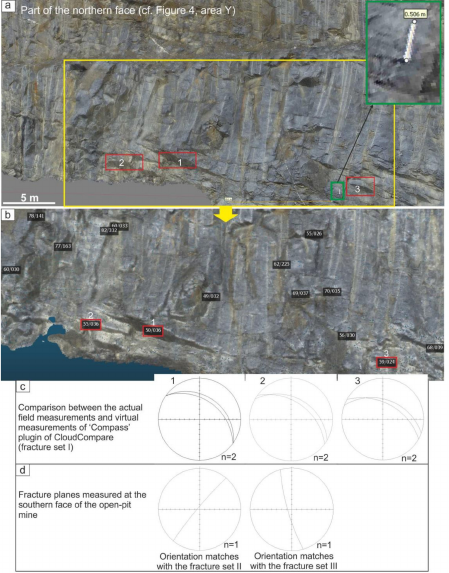
Figure 6. Comparison of virtual ‘Compass’ measurements and field data. ( a , b ) Fractures labeled 1, 2, and 3 exposed at the bottom of the pit wall (highlighted in red boxes) that were used to check the orientations obtained with the ‘Compass’ tool. All of the fractures belong to Set I. Inset (green box) in ‘a’ shows length of the 50 m scale bar measured in the Photoscan. ( c ) Orientations measured in the field and virtually with the ‘Compass’ plugin showing a very close match. ( d ) Fracture belonging to set II and III measured on the southern face of the open pit with a similar orientation as those measured with the ‘Compass’ plugin from the northern face (cf. Figure